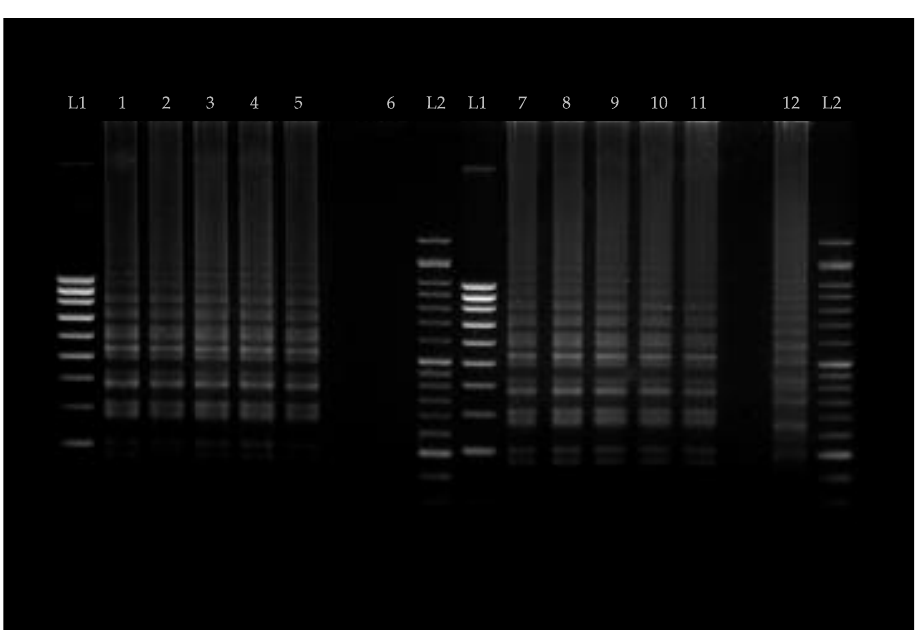
Figure 8. Evaluation of the LAMP-amplified DNA obtained following P100–MBs mediated lysis of Figure 6. Inclusivity of the LAMP assay evaluated through agarose gel electrophoresis. The experi- L. monocytogenes isolated from pasteurized milk and DNA extracted from pure bacterial cultures. ments were conducted at 62 °C (lanes 1 to 6) and 63 °C (lanes 7 to 12). Lanes 1 and 7, Lm 1/2a; lanes Lanes: 1,6—P100–MBs mediated lysis of L. monocytogenes -10 3 CFU mL − 1 ; 2,7—10 2 CFU mL − 1 ; 2 and 8, Lm 4b; lanes 3 and 9, Lm 1/2b; lanes 4 and 10, Lm 1/2c; lanes 5 and 11, Lm reference strain 3,8—10 CFU mL − 1 ; 4,9—5 CFU mL − 1 ; 5,10—1 CFU mL − 1 ; NTC—non-template control (10 3 (EGDe); lanes 6 and 12, non-target DNA control. Lanes L1 and L2, molecular weight marker (NZY- DNA Ladder V and VI).